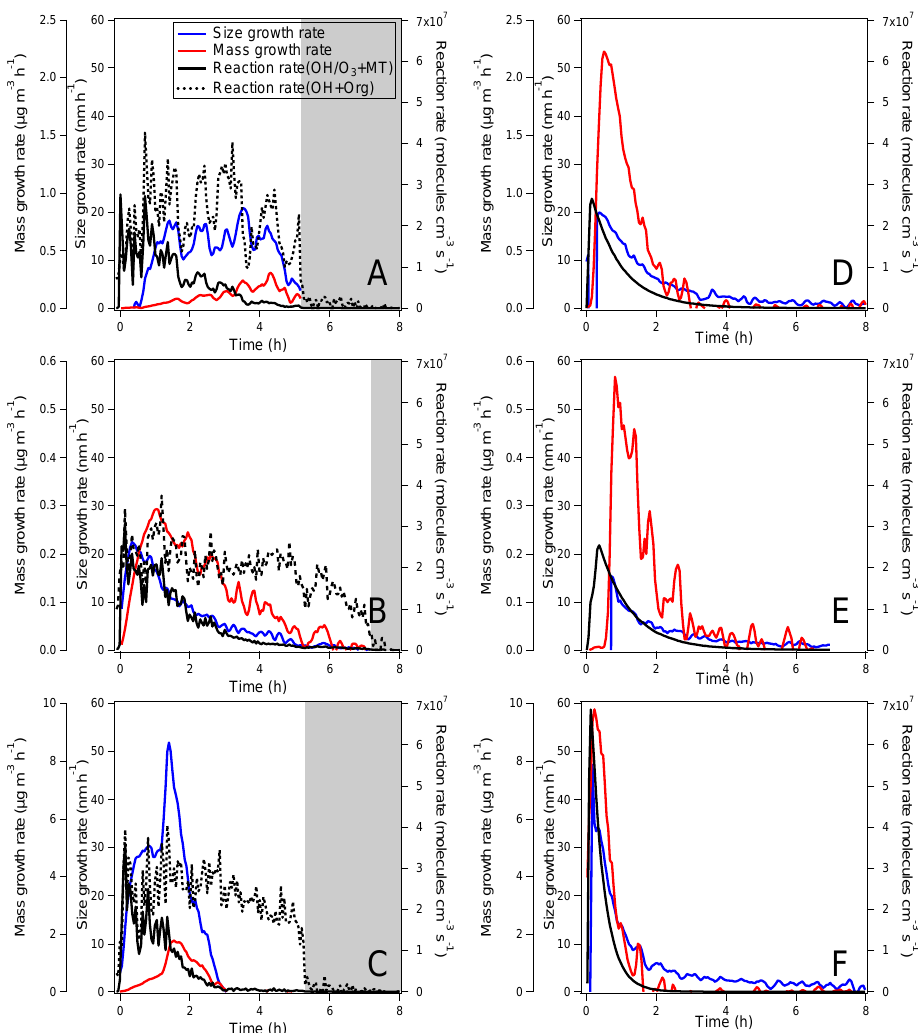
Figure 4. Particle size growth rate, mass growth rate and reaction rate of OH or O 3 with α -pinene (a, d) , β -pinene (b, e) and limonene (c, f) . The left panels are from OH oxidation (the shaded area shows the dark period) and right panels from ozonolysis in the presence of CO as OH scavenger. For the OH oxidation, the overall reaction rate of OH with total organics (reaction rate(OH + Org)) is also shown.